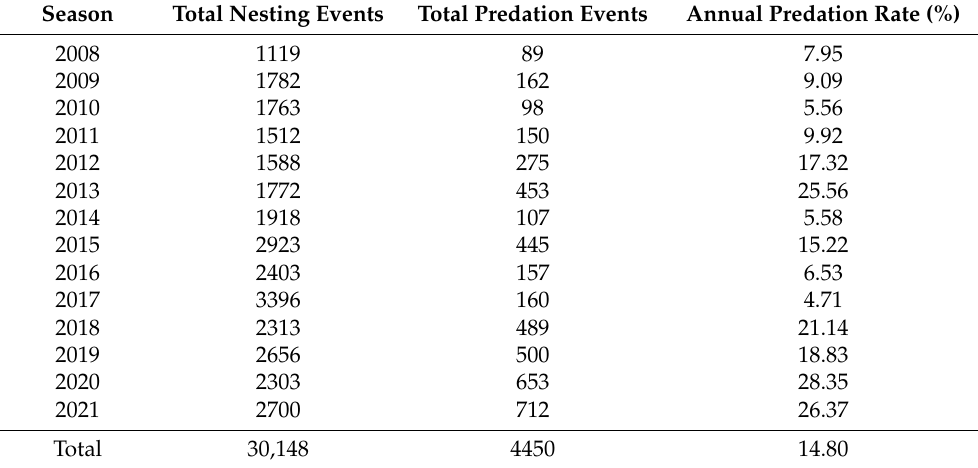
Table 1. Predation Rates (%) of Olive Ridley sea turtle nests in Corozalito, from 2008 to 2021. Percentage values are relative to the total number of nesting events. Total predation events include both partial and complete predated nests.